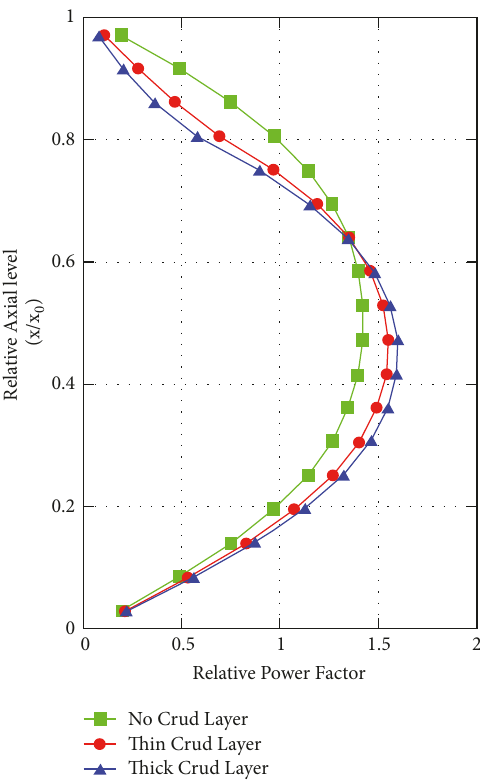
Figure 7: Axial power shift indicates the CIPS.